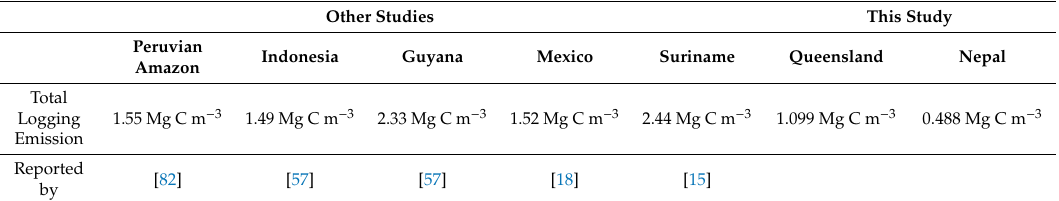
Table 10. Total Logging emissions from di ff erent